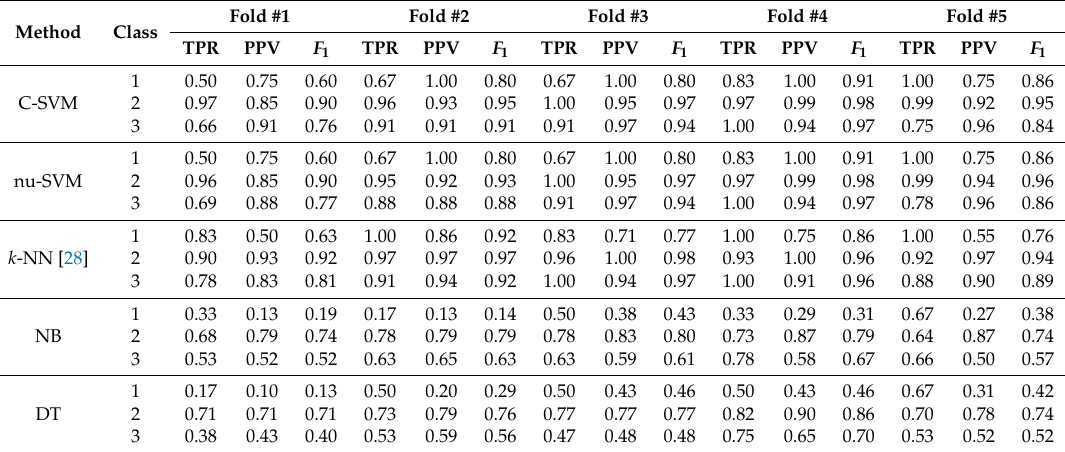
Table 6. Five-fold cross-validation results of the five benchmark methods when the synthetic minority oversampling technique (SMOTE) is used.